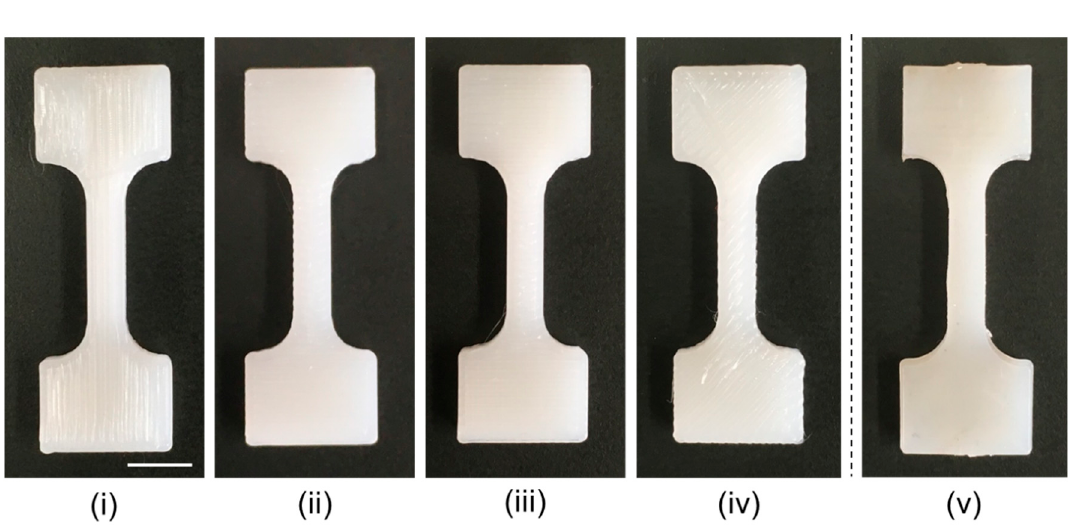
Figure 4. Photographs of the test pieces. Test pieces ( i – iv ) were fabricated by FFF using scan